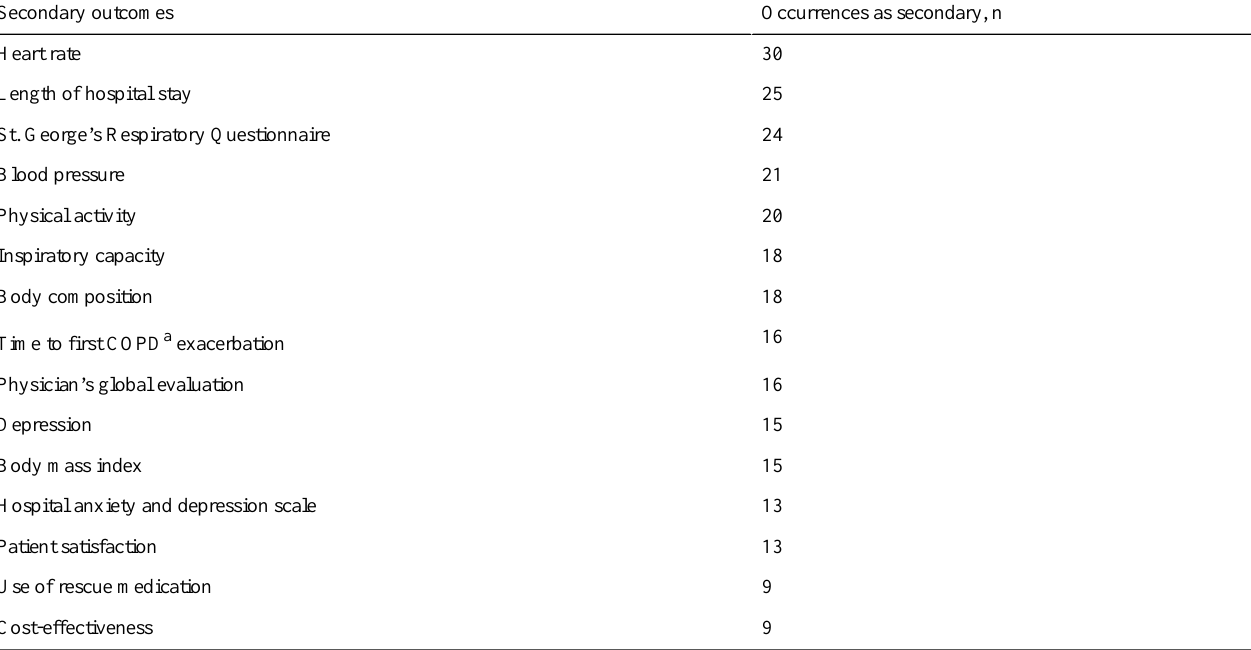
Table 3. Top 15 secondary outcomes identified by the pipeline, excluding outcomes occurring frequently as primary.